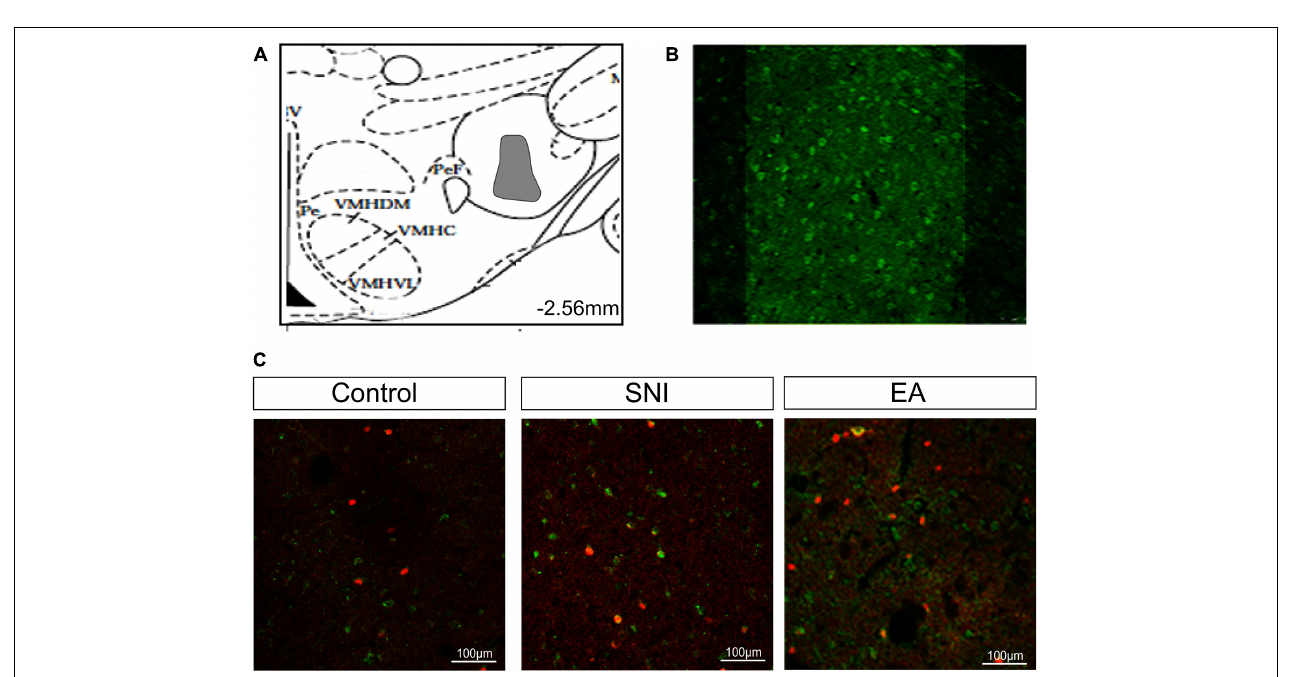
FIGURE 6 | Activated afferents from the LH to the NAc shell using CTb/c-Fos double immunohistochemistry after EA induced CPP. (A) The maximum extent of CTb-IR (indicated gray area) in the LH. (B) Fluorescent photomicrographs of representative injection sites of 30 nL of CTb in the LH. (C) Representative immunofluorescence images for CTb/c-Fos in the NAc shell. Scale bar, 100 µ m.